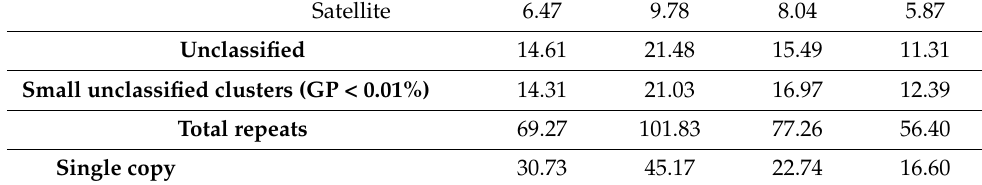
Small unclassified clusters (GP <